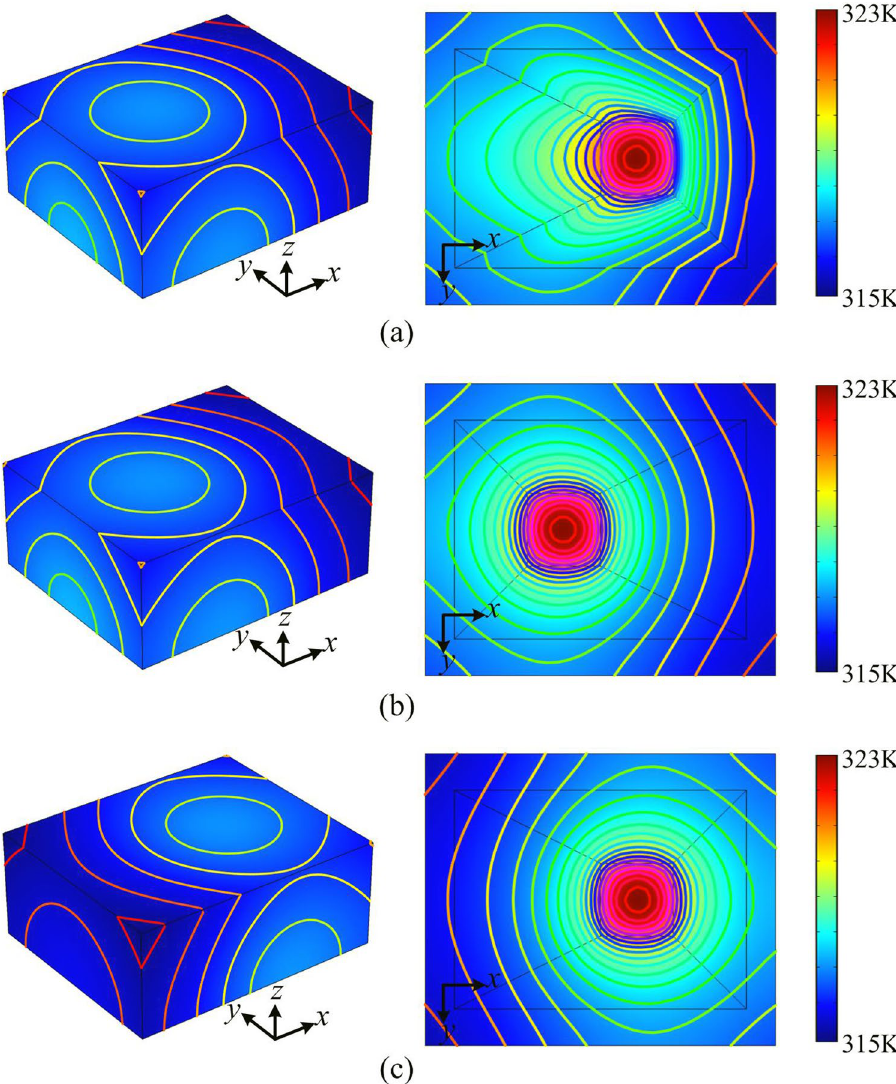
Figure 2. The simulated temperature profiles produced by heat sources. ( a ) The heat source is placed on the right part of the system and covered by the illusion thermal device. ( b ) The heat source is placed on the left part of the system without thermal device. ( c ) The heat source is placed on the right part of the system without thermal